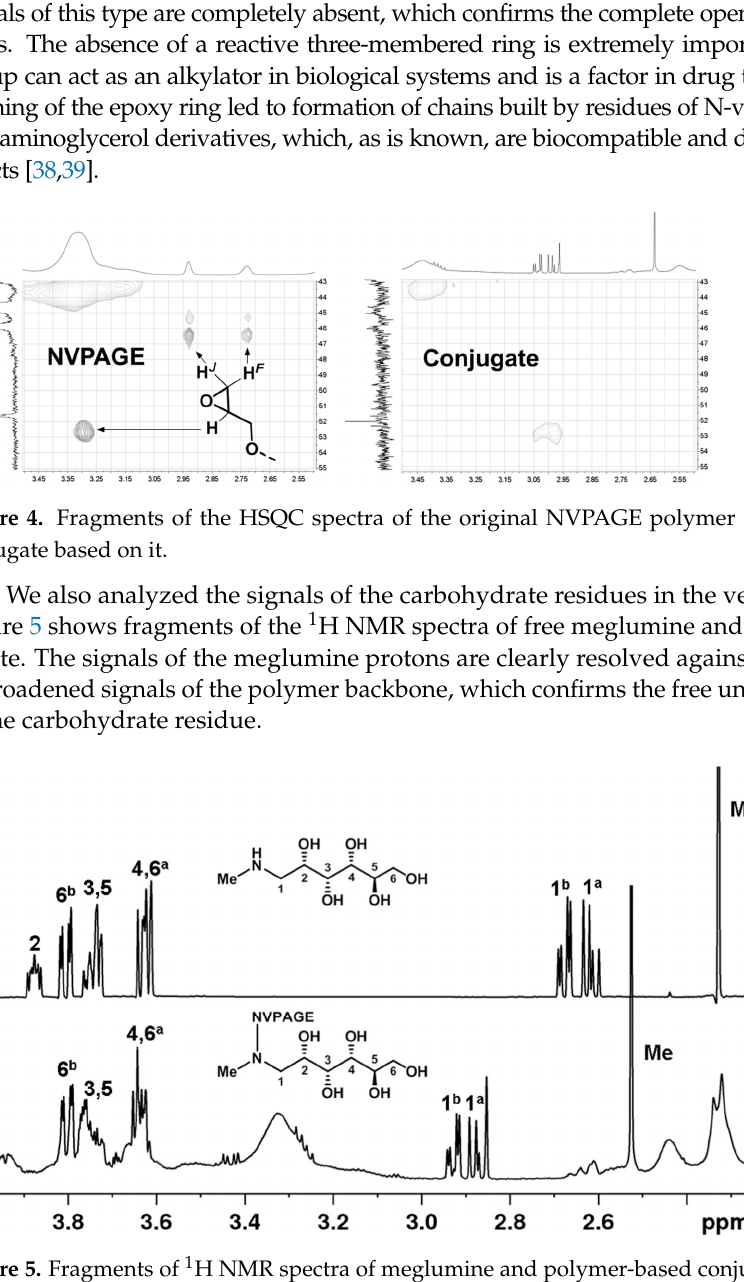
Table 2. Chemical shifts of the 1 H and 13 C atoms in the NMR spectra of free meglumine and the meglumine residue in the polymer-based conjugate.